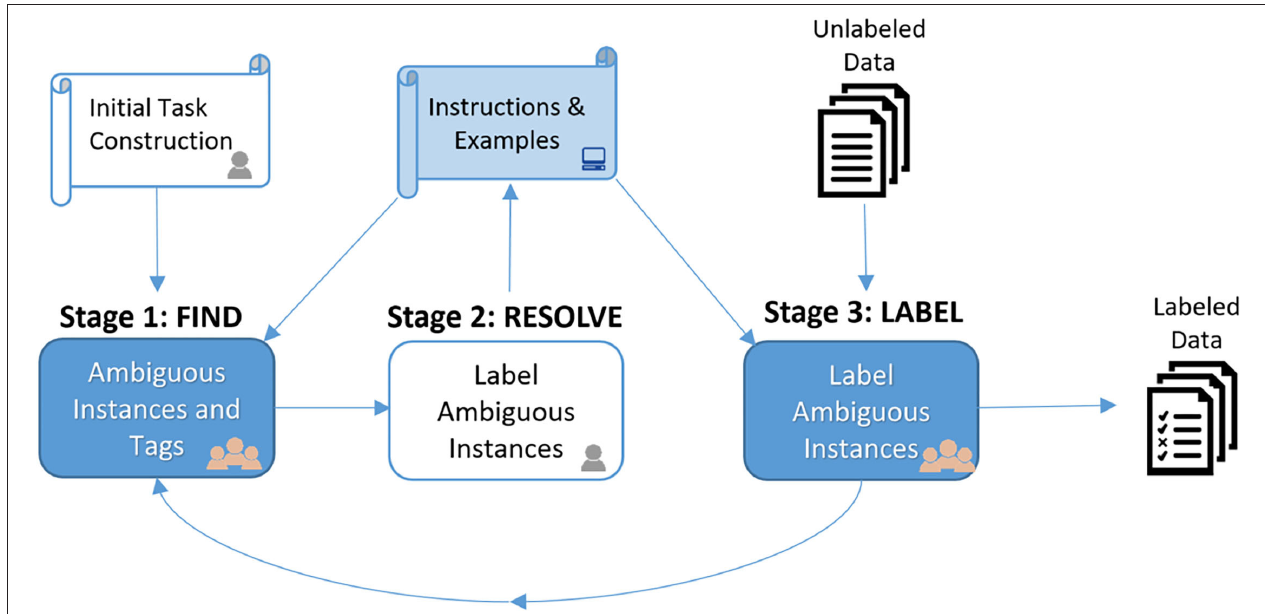
FIGURE 1 | Our Three-Stage FIND-RESOLVE-LABEL workflow is shown above. Stage 1 (FIND) asks the crowd to find examples whose correct label seems ambiguous given the task instructions (e.g., using external Internet search or database lookup). In Stage 2 (RESOLVE), the requester selects and labels one or more of these ambiguous examples. These are then automatically injected back into task instructions in order to improve clarity. Finally, in Stage 3 (LABEL), workers perform the actual annotation using the revised guidelines with clarifying examples. If Stage 3 labeling quality is insufficient, we can return to Stage 1 to find more ambiguous examples to further clarify